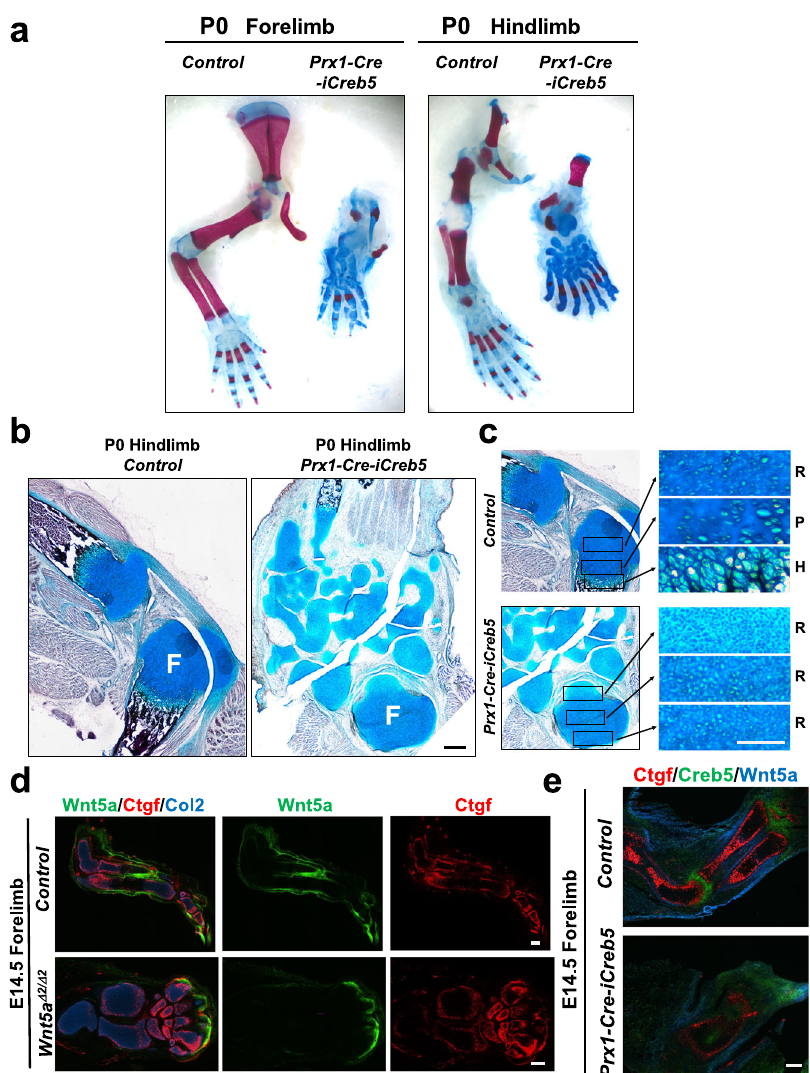
Fig. 6 | Misexpression of iCreb5-HA (Prx1-Cre) blocks growth plate formation and phenocopiesaspectsofWnt5a lossoffunction.a AlcianBlue/AlizarinRed whole mount staining and b , c Von Kossa/Alcian Blue staining of indicated limbs from either P0 Prx1-Cre-iCreb5 mice or control littermates. Femur (F), Resting zone chondrocytes (R), Proliferating zone chondrocytes (P) and Hypertrophic zone